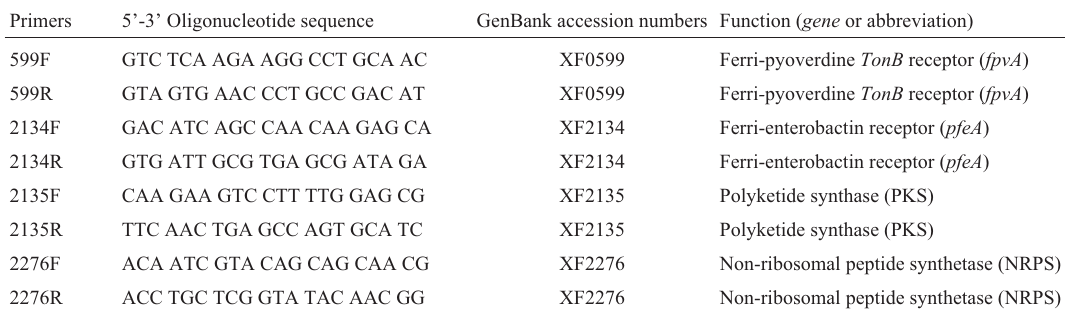
Table 2 - Primers based on the specific sequences of Xylella fastidiosa strain 9a5c that were used in this study. Primers 5’-3’ Oligonucleotide